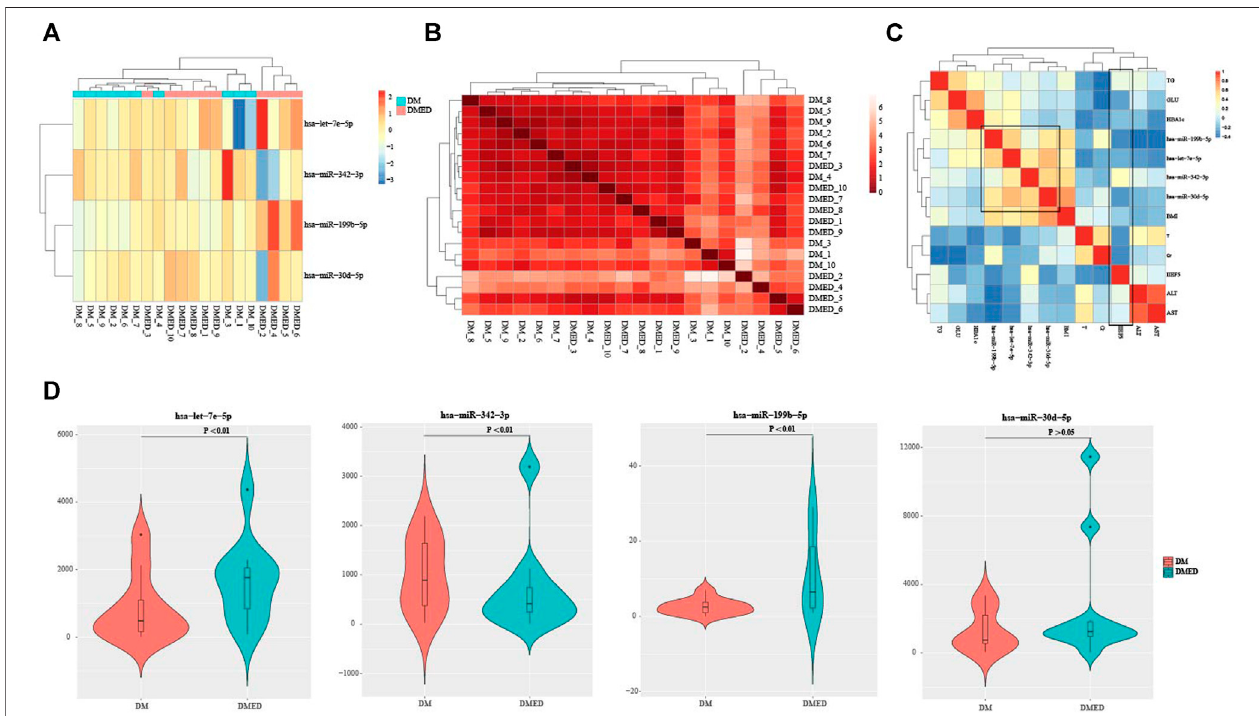
FIGURE 2 | The veri fi cation of DMEDSig-4 classi fi cation ability and the association of clinical information. (A) Clustering heat map of DMEDSig-4 in DM and DMED groups. Red: Up-regulated expression; Blue: Down-regulated expression. (B) Heat map ofsimilarity between DM groups and DMED groups. (C) Correlation analysis of DMEDSig-4andclinicalfactors.BMI,bodymassindex,IIEF5,internationalindexoferectilefunction5;HbA1c,glycatedhemoglobin;TT,testosterone;GLU,glucose;Cr, creatinine; TG, triglyceride; ALT, Alanine transaminase; AST, aspartic acid transaminase. (D) Violin diagram of differential expression of DMEDSig-4 in DM and DMED